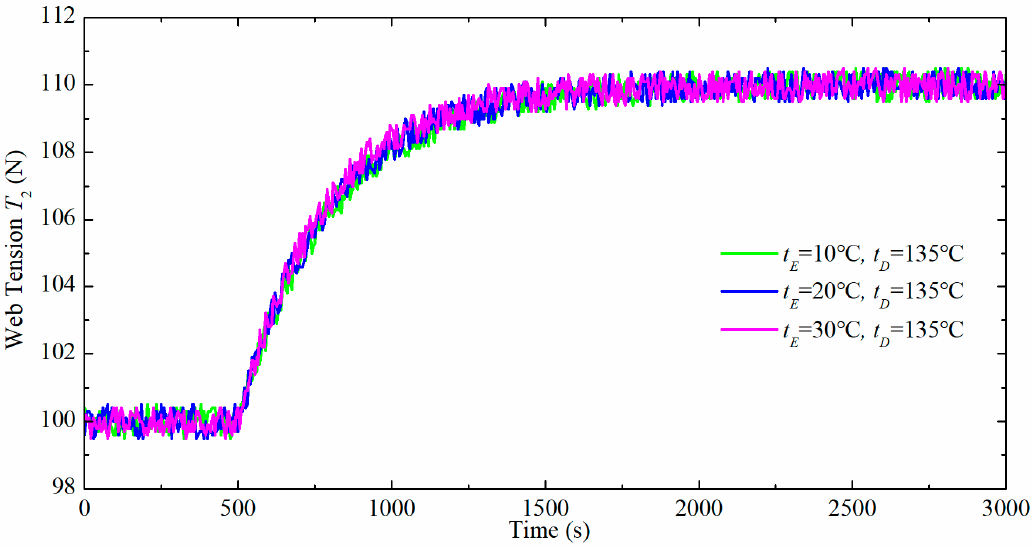
( ) T t as ( ) T t has step changes at different room 2 1